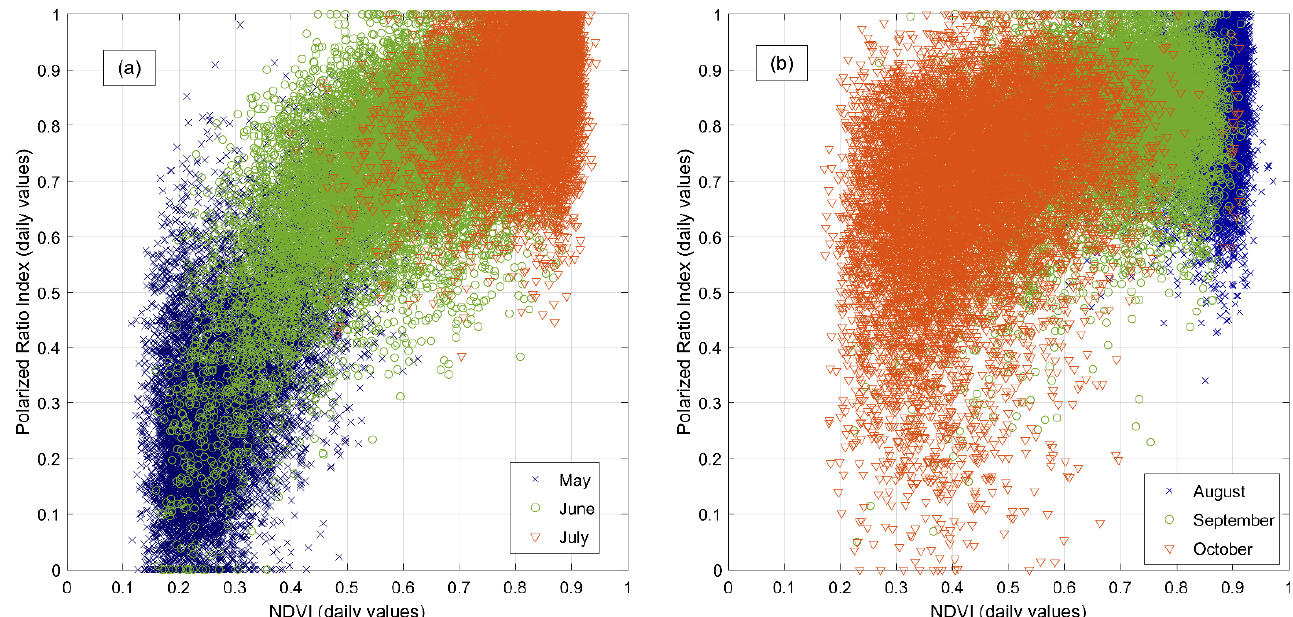
Figure 4. Comparison of daily NDVI and daily Polarized Ratio Index (IPR) over maize fields, for different growing stages. ( a ): May–June–July period; ( b ): August–September–October period. Each point represents the comparison between daily NDVI and IPR for a specific field. During the middle and final phases, plants have reached the maximum stage of development (NDVI variability is very low and mainly due to plant health status) and the crop response in terms of NDVI is due to the change of plant color and to the final harvesting.